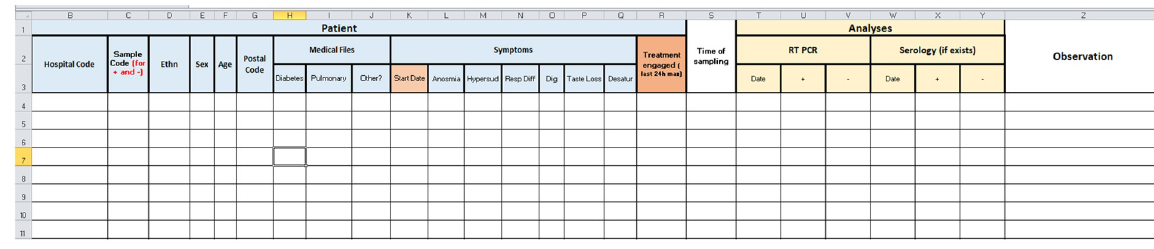
Fig 4. Anonymous form for each coded